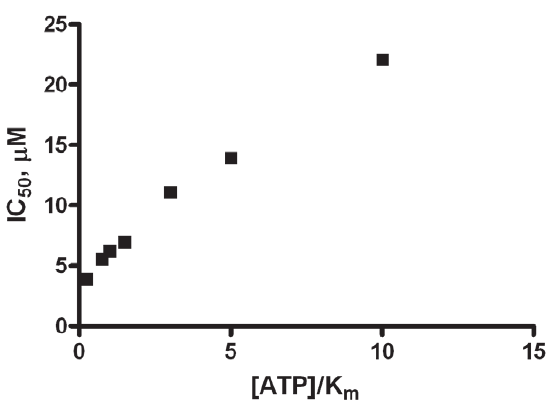
Figure 6. ATP competition with tyrphostin I-OMe-AG-538. The IC 50 of tyrphostin I-OMe-AG-538 for PI5P4K a is plotted against the [ATP]/K m . The K m of ATP is 5 m M, and seven concentrations were